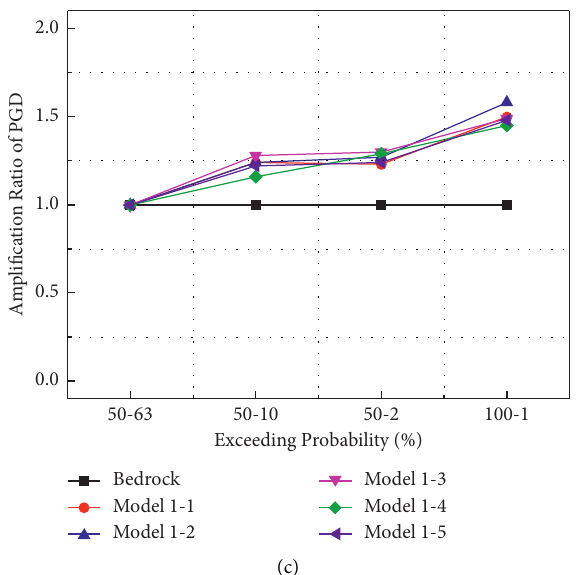
Figure 3: Amplification ratios of ground motion for the five single interbedded models under four seismic inputs.